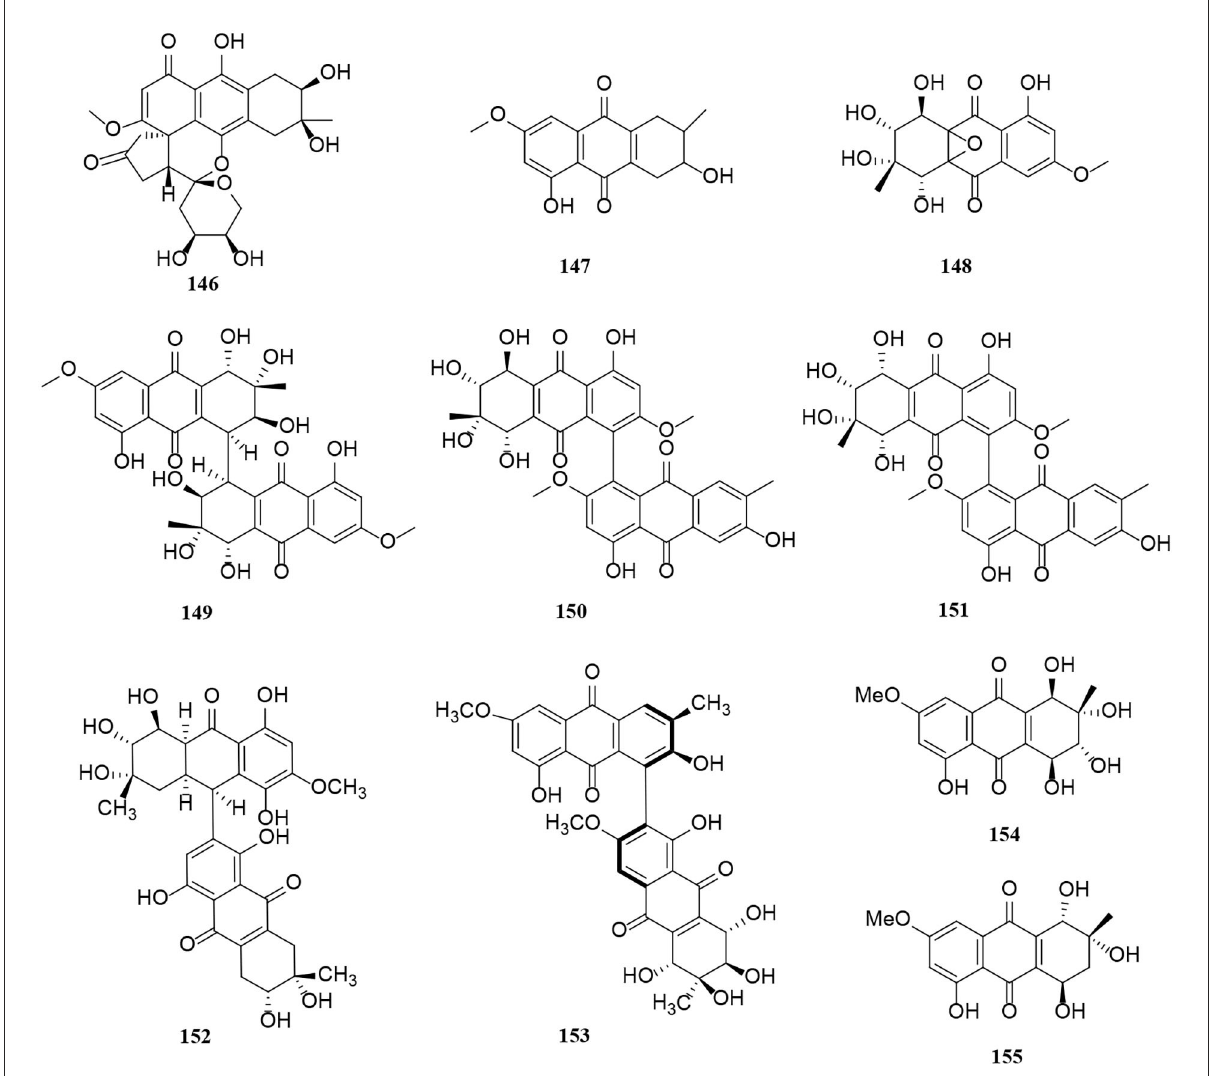
FIGURE9 Anthraquinone derivatives ( 146 – 155 ) from Alternaria